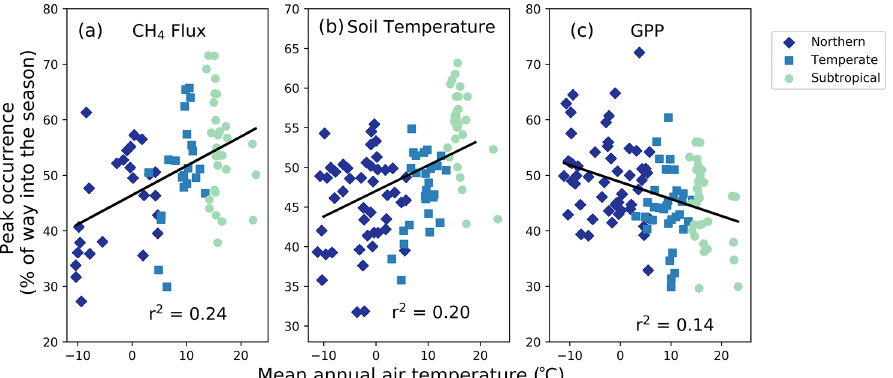
Figure 12. Site-year peak methane (CH 4 ) emissions (a) and peak soil temperature (b) occur earlier in the season for sites with lower mean annual temperatures. (c) Gross primary productivity (GPP) tends to peak earlier in the season for warmer sites, though the trend is weak. All r 2 values are significant at p < 0.001. Each point represents a site year of